Question: Produce a descriptive caption suitable for publication.
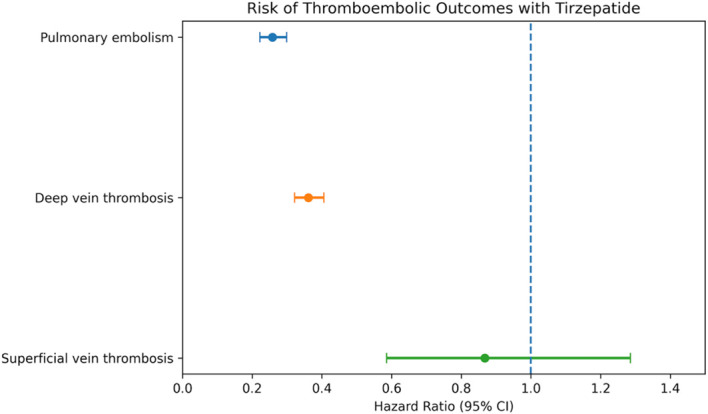
Answer: Baseline characteristics of propensity score-matched cohorts.